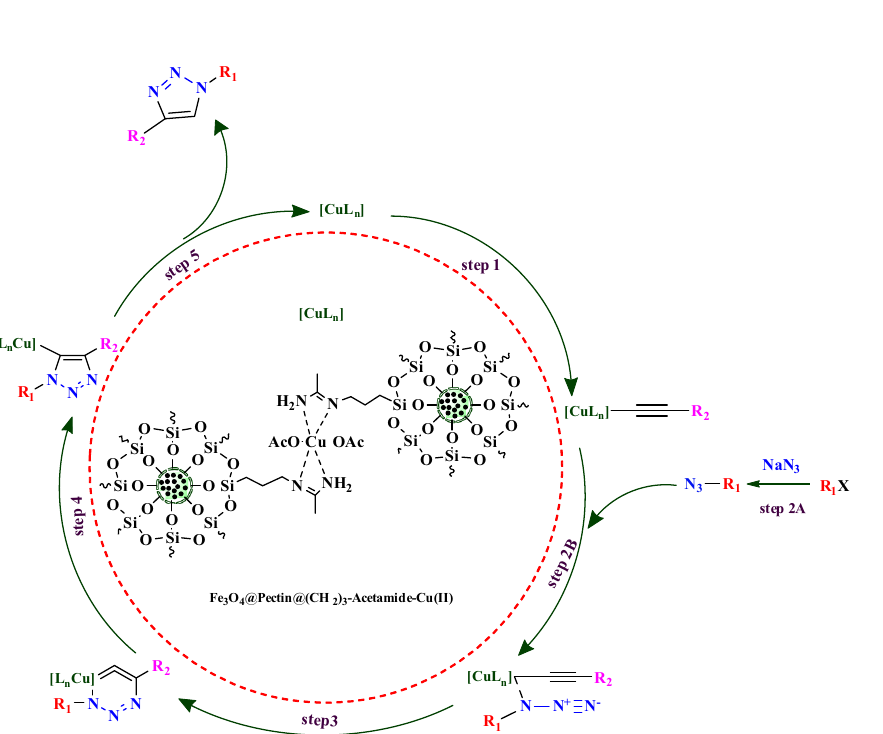
Figure 10. Plausible mechanism for synthesis of 1,2,3-triazole derivatives by Fe 3 O 4 @Pectin@(CH 2 ) 3 - Acetamide-Cu(II) NPs